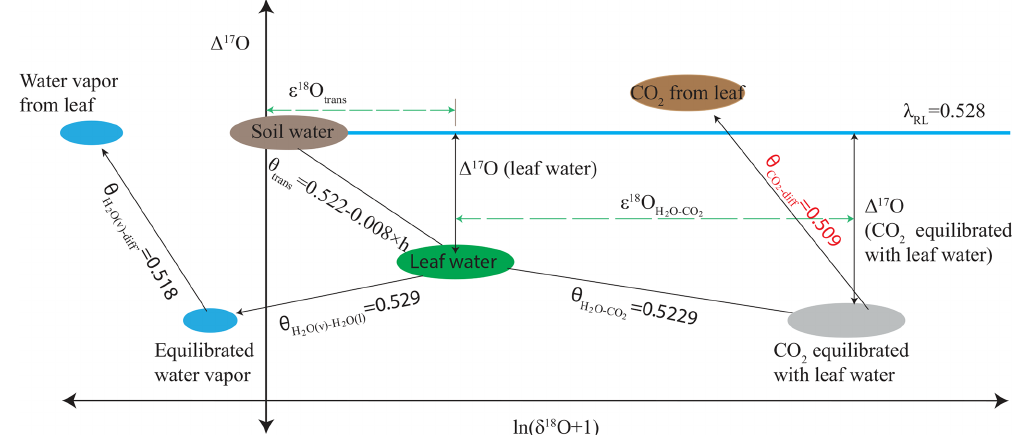
Figure 1. Schematic for mass-dependent isotope fractionation process that affects the (cid:49) 17 O of the CO 2 and H 2 O during the photosynthetic gas exchange (not to scale). The triple oxygen isotope relationships for the individual isotope fractionation processes (both kinetic and equilibrium fractionation) are assigned with θ . θ trans = 0 . 522 − 0 . 008 × h , where h is relative humidity (Landais et al., 2006). In this study the humidity is 75%, θ trans = 0 . 516, θ CO (Barkan and Luz, 2012), θ CO (Young et al., 2002), θ H (Barkan and Luz, 2 − H 2 O 2 − diff 2 O ( v ) − H 2 O ( l ) 2005), and θ H (Barkan and Luz, 2007), where v and l are vapor and liquid water, respectively. ε 18 O is enrichment or depletion 2 O ( v ) − diff in 18 O isotope composition due to the corresponding isotope fractionation process, and diff and trans stand for diffusion and transpiration,